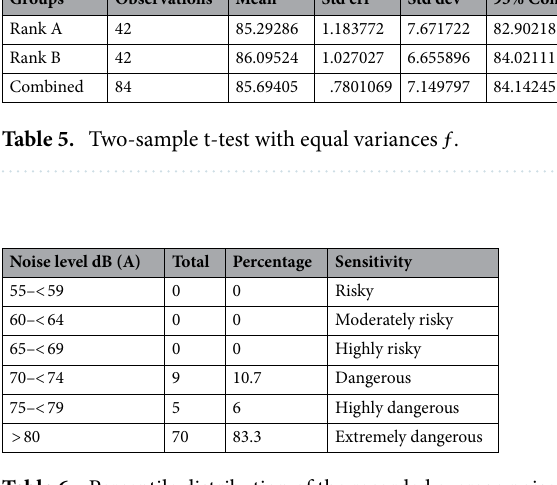
Table 6. Percentile distribution of the recorded average noise levels.